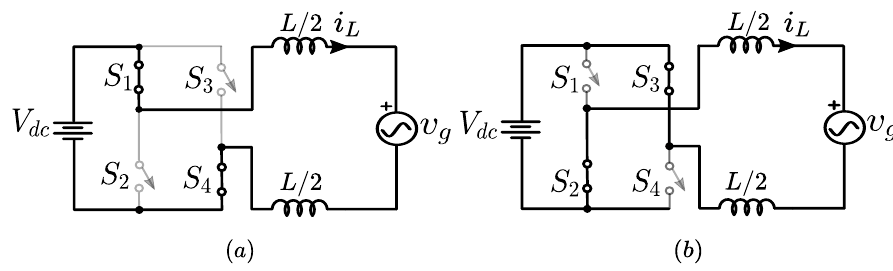
Figure 2. The switching states ( a ) S + and ( b ) S − during the positive half